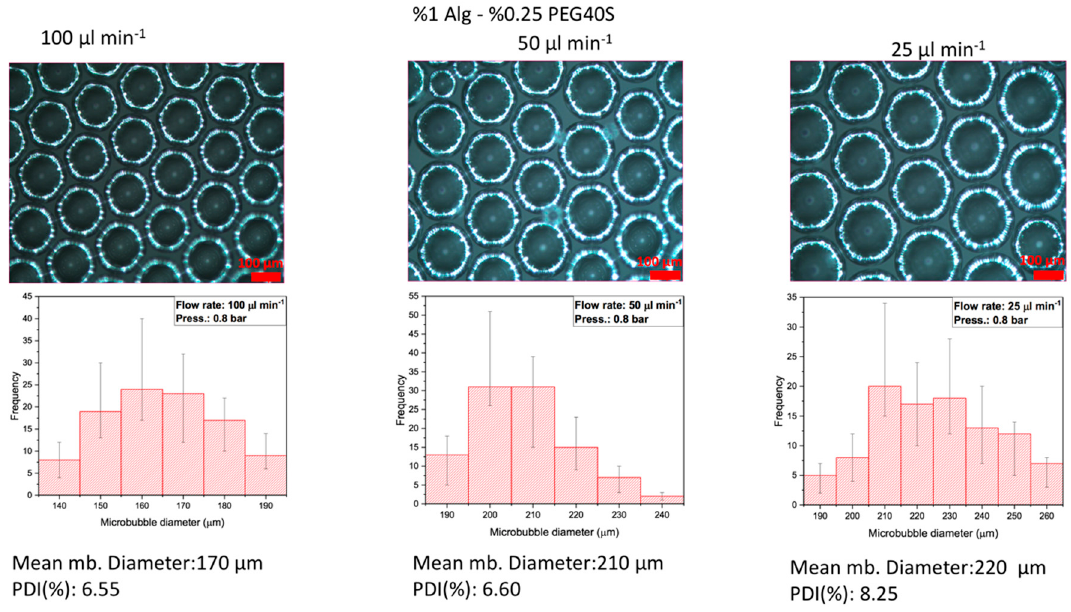
Figure 2 . Changes of microbubble (mb) diameter and size distribution as a function of the feeding liquid ′ s flow rate at a constant N 2 gas pressure of 0.8 bar. Data are presented as mean ± SD, n ≥ 100